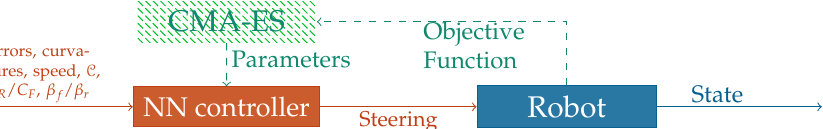
Figure 1. Overview of the RL steer method. Dashed section designates the optimizer that is only used for training.